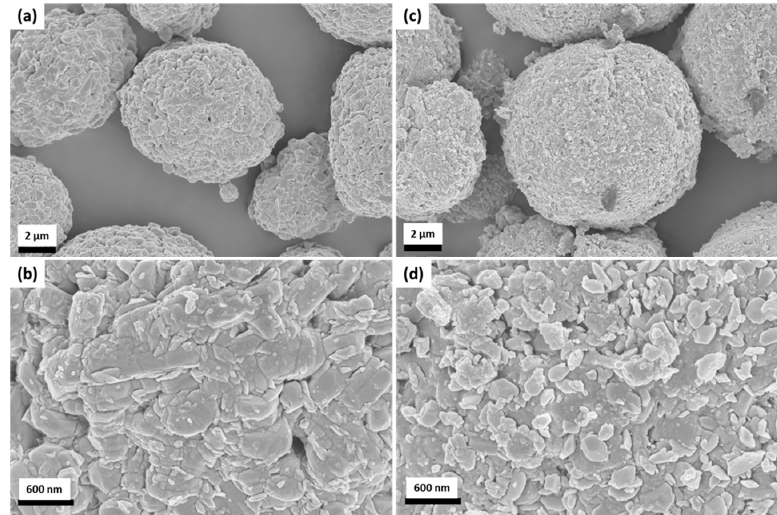
Figure2. SEMimagesof( a , b )pristineand( c , d )SiO 2 -coatedNMC622particlesindi ff